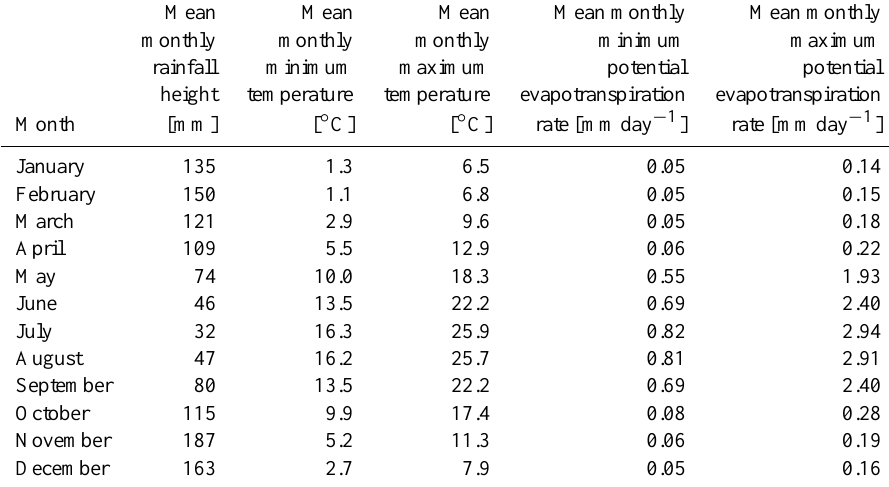
Table 3. Monthly mean climatic characteristics of Cervinara and corresponding estimated potential evapotranspiration fluxes. Mean Mean Mean Mean monthly Mean monthly monthly monthly monthly minimum maximum rainfall minimum maximum potential potential height temperature temperature evapotranspiration evapotranspiration Month [mm] [ ◦ C] [ ◦ C]